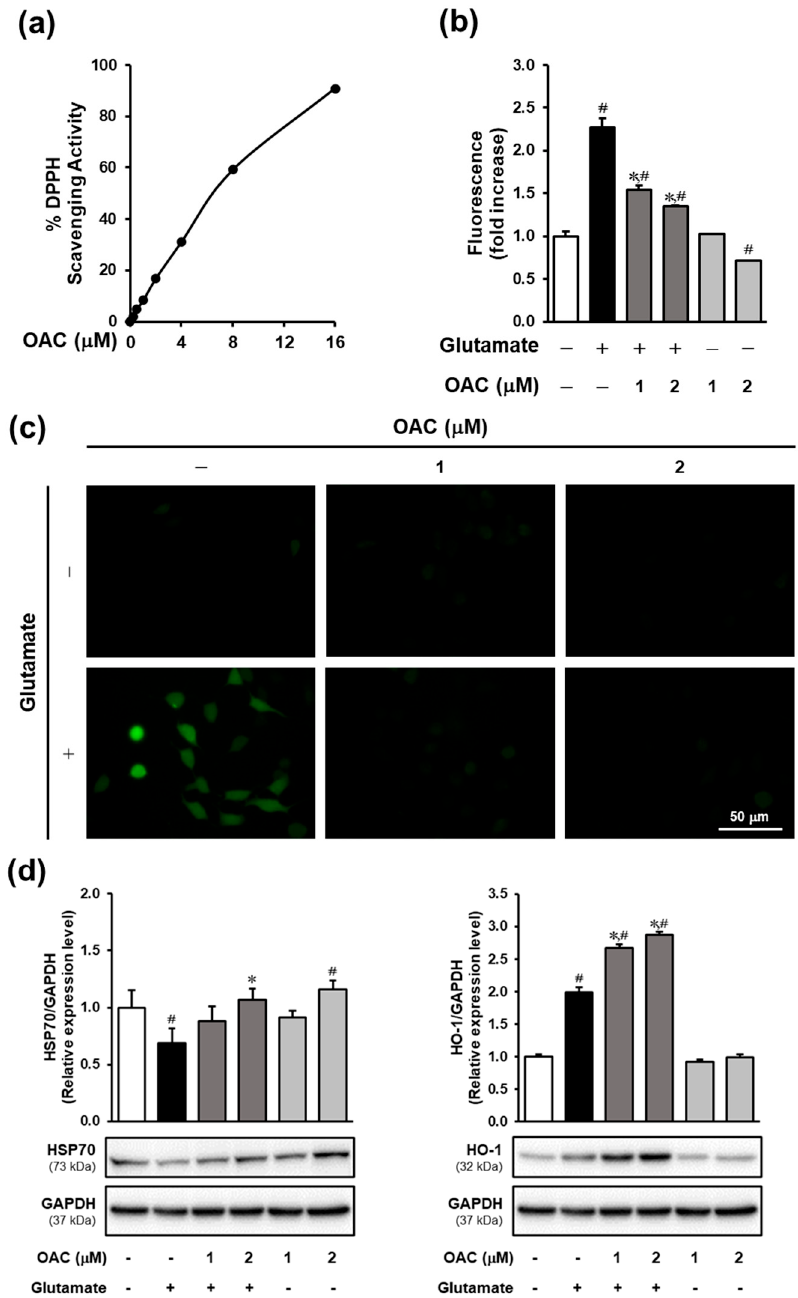
Figure 2. Effect of OAC against oxidative stress caused by the excess of glutamate in HT22 cells. ( a ) Antioxidant effect of OAC via DPPH scavenging activity; the IC 50 was 7.88 ± 0.02 μ M. ( b ) OAC significantly reduced the level of glutamate-induced ROS in a dose-dependent manner ( ∗ p < 0.005 vs. glutamate-treated group; # p < 0.005 vs. non-treated group). ( c ) Fluorescent images of H 2 DCF- DA staining. ( d ) Effect of OAC on the expression of oxidative stress-response enzymes ( ∗ p < 0.05 vs. glutamate-treated group; # p < 0.05 vs. non-treated group). GAPDH was used as a loading control. OAC: osmundacetone; DPPH: 2,2-diphenyl-1-picrylhydrazyl; ROS: reactive oxygen species; HSP70: heat shock protein 70; HO-1: heme oxygenase-1; GAPDH: glyceraldehyde-3-phosphate de- hydrogenase.